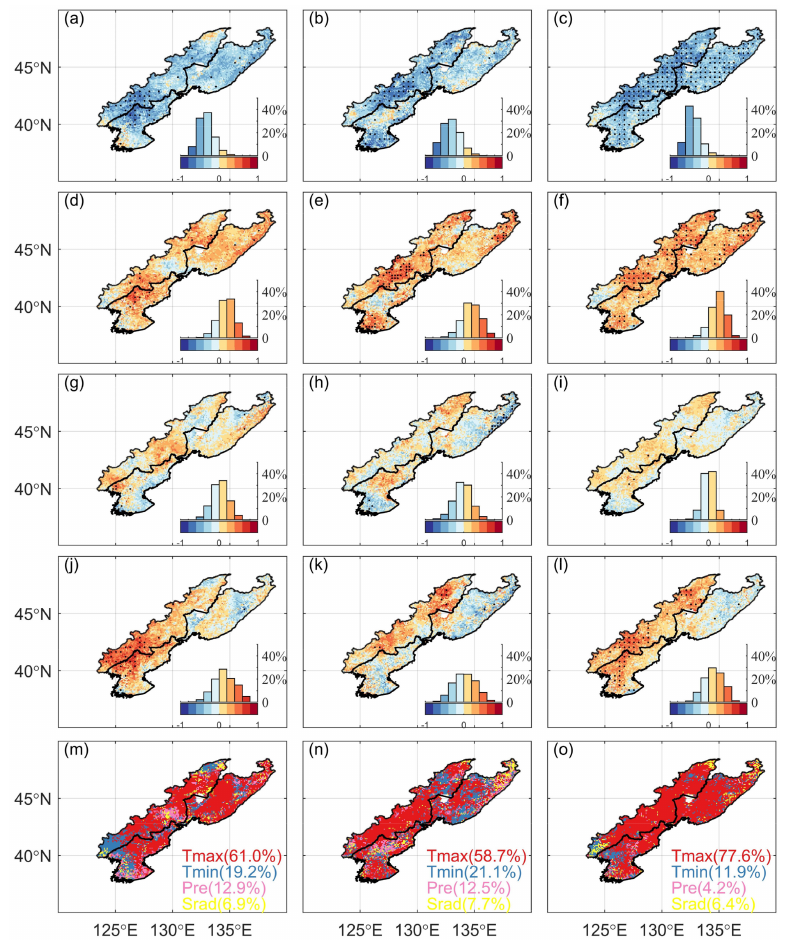
Figure 5. The response of SOS to changes in Tmax, Tmin, precipitation and solar radiation in the China–DPRK–Russia cross-border area. ( a ) Spatial distribution of the partial correlation coefficient between SOS and Tmax from 1982 to 1998. ( b ) Spatial distribution of the partial correlation coefficient between SOS and Tmax from 1998 to 2015. ( c ) Spatial distribution of the partial correlation coefficient between SOS and Tmax from 1982 to 2015. ( d ) Spatial distribution of the partial correlation